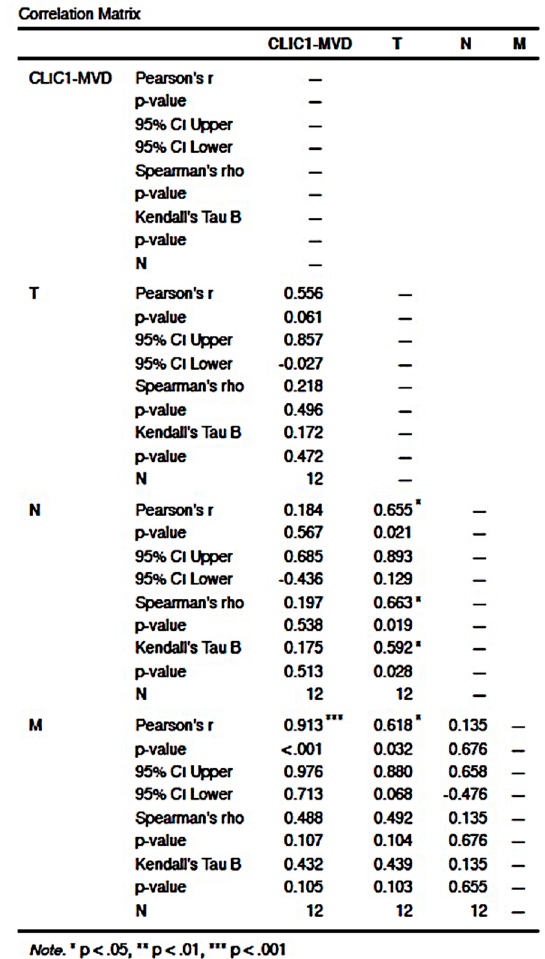
Figure 6. Correlation plot for the NMC subgroup related to CLIC1-MVD and the TNM staging pa- rameters.